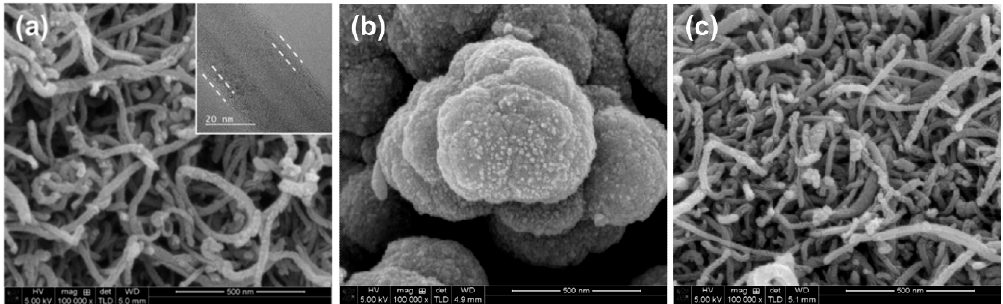
Figure 2. ( a – c ) Scanning electron microscopy (SEM) images of ( a ) multi-wall carbon nanotube (MWCNT)-polypyrrole core-shell nanowire, ( b ) polypyrrole, and ( c ) surface-modified MWCNT. The inset of ( a ) is a transmission electron microscopy (TEM) image of corresponding core-shell nanowire.